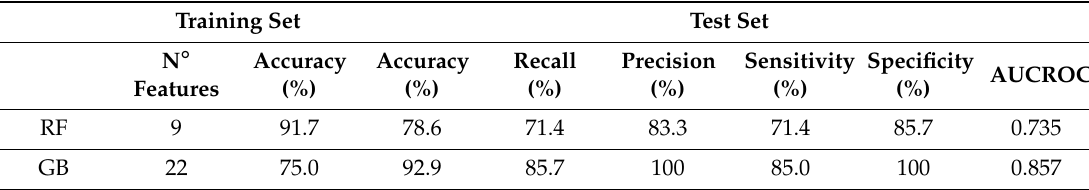
Table 1. Scores for training and test set for the classification task.